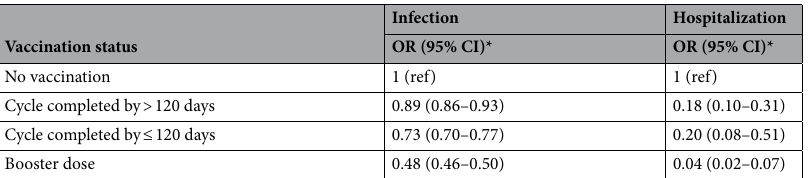
Table 2. Odds ratios (OR) and 95% confidence intervals (95%CI) for the association between joint effect of vaccination and previous infection and risk of new infection and hospitalization occurred after December 1st, 2021. *Adjusted for age, sex (matching) and vulnerability